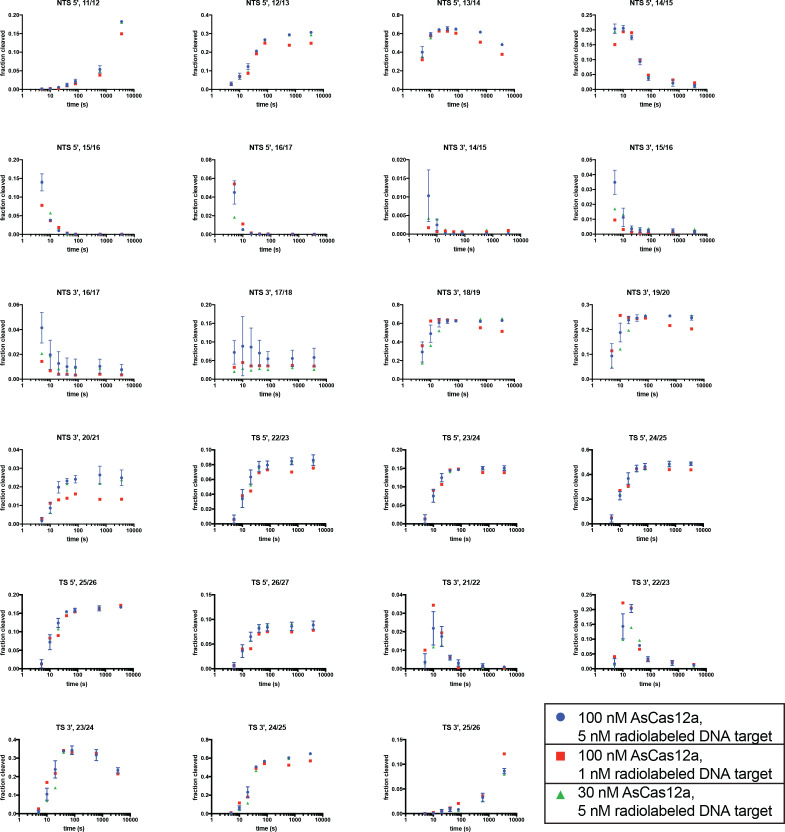
Concentration dependence of phosphodiester-mapped cleavage events.Each graph follows the kinetics of appearance/disappearance of a cleavage product at the indicated phosphodiester. ‘Fraction cleaved’ is defined as (band volume for a given cleavage product)/(total volume in lane). For example, ‘NTS 5', 11/12’ displays the fraction of 5'-radiolabeled NTS that was detected to have been cleaved at the 11/12 dinucleotide for each timepoint. Blue circles are equivalent to the data shown in Appendix 2—figure 1, with error bars denoting standard deviation across three replicates. Red squares and green triangles indicate variants of this experiment in which the total concentration of either DNA-bound holoenzyme (red squares) or AsCas12a/crRNA (green triangles) was decreased. The fact that almost all species exhibit equivalent kinetics of appearance/disappearance in all three conditions (with the potential exception of the phosphodiesters on the portion of the PAM-distal NTS fragment that remains single-stranded after release by the enzyme, which exhibit slight concentration-dependence on longer timescales) indicates that we are observing mostly cis cleavage events, as explained in Appendix 2—figure 1—figure supplement 4.